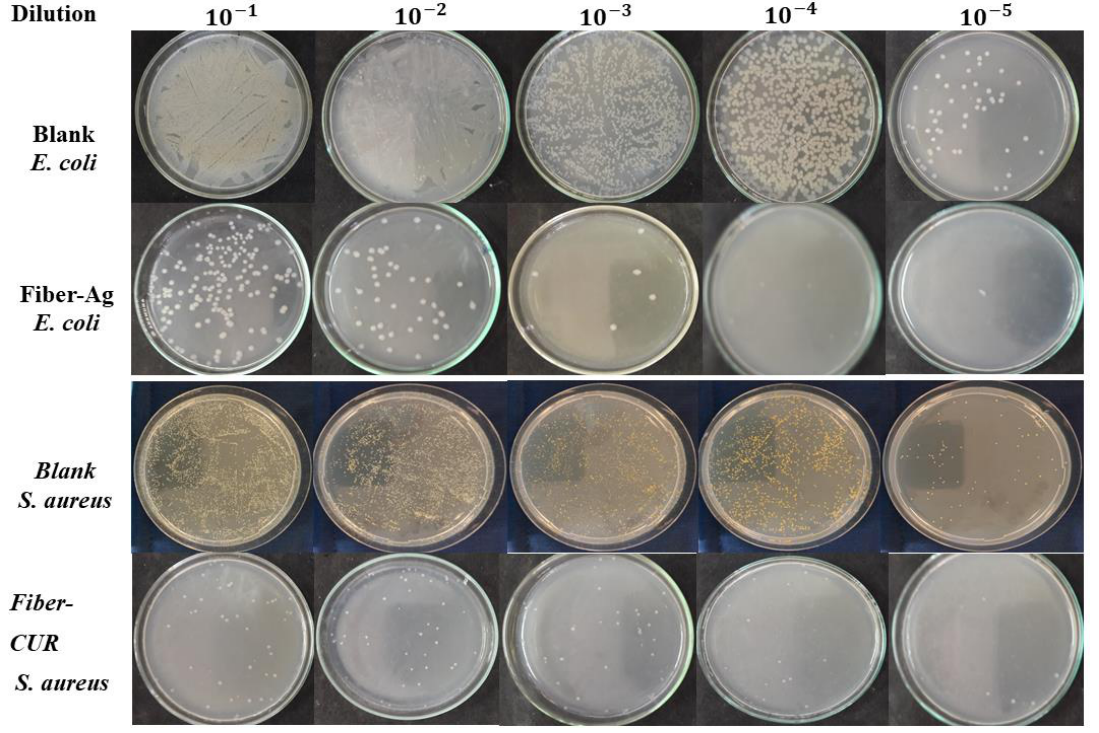
Figure 22. Antibacterial activity of PBS fibers loaded with curcumin or silver